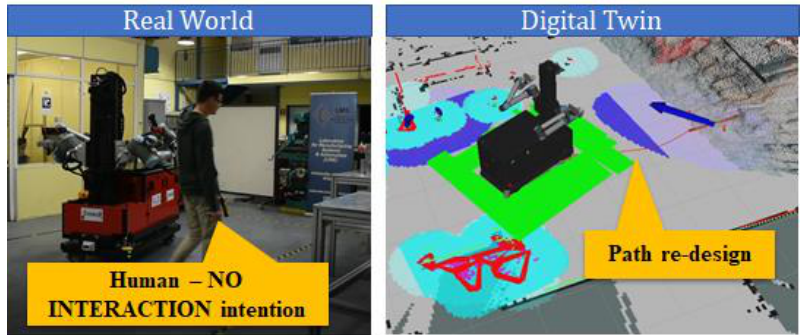
Figure 13. Human NO INTERACTION intention detected.